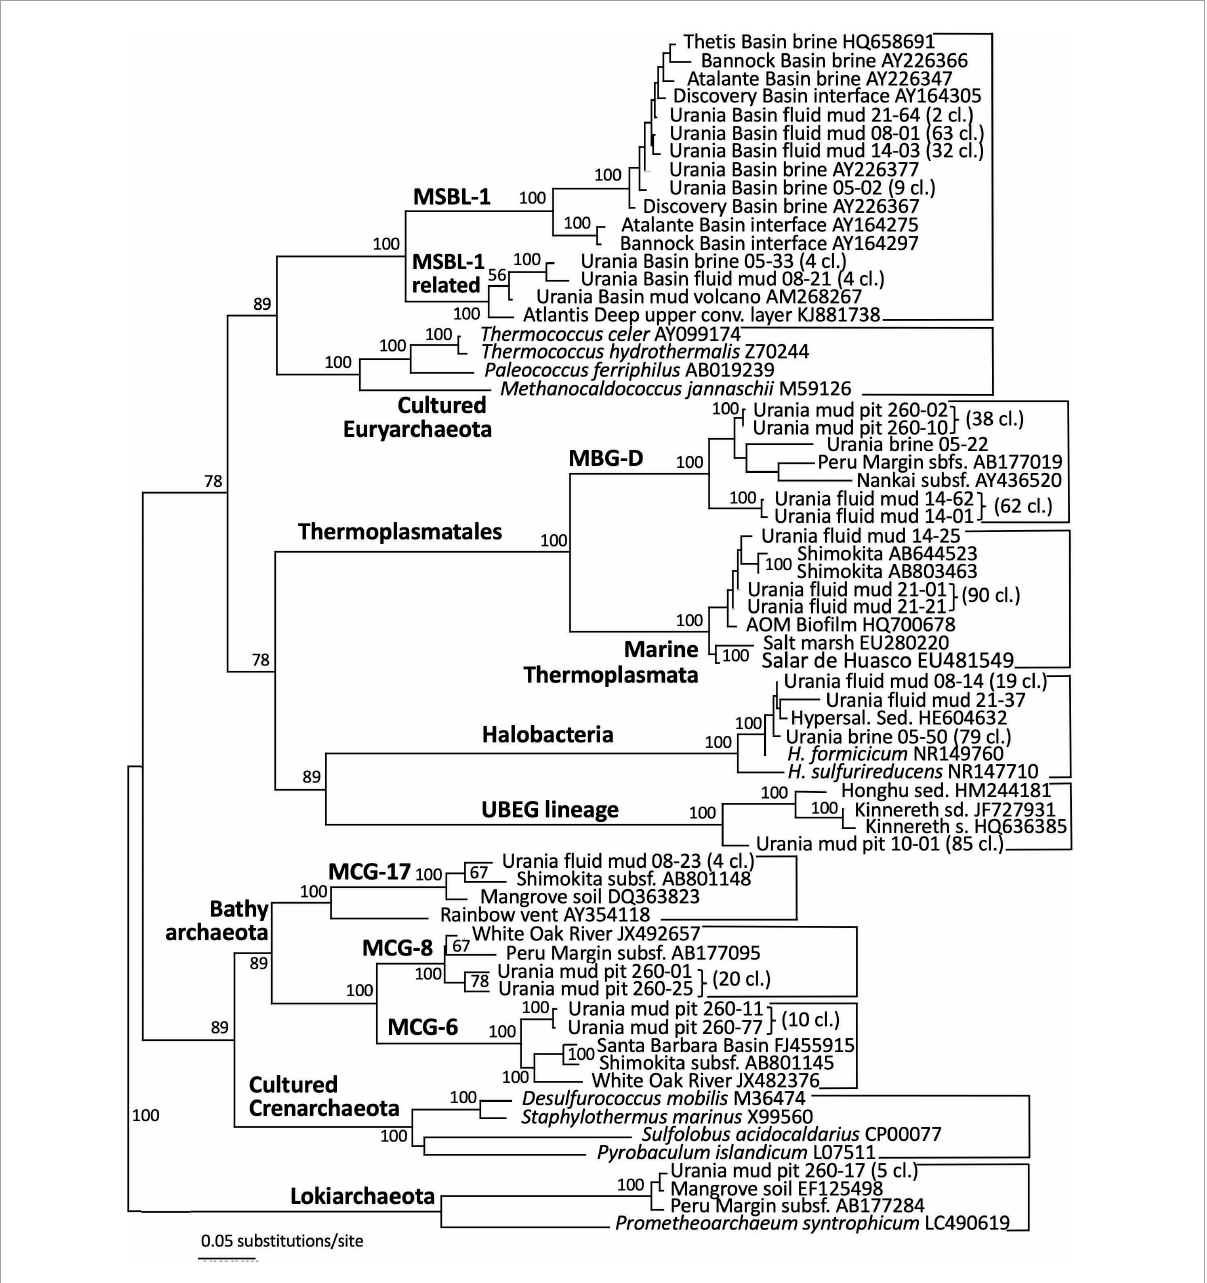
FIGURE5 Phylogeny of the Archaea-affiliated 16S rRNA genes based on distance minimum evolution analysis and 1,000 neighbor-joining bootstrap iterations using PAUP (Swofford, 2000).